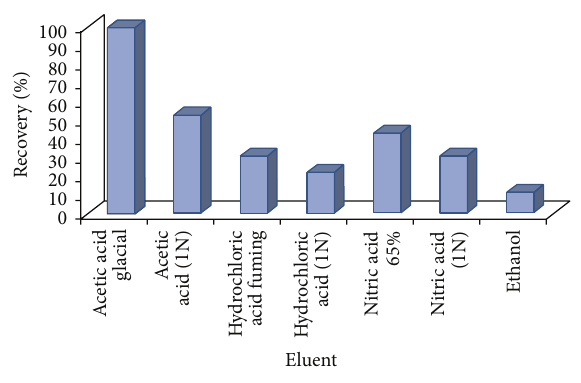
Figure 9: Effects of various eluents on the recoveries of CV (eluent volume: 1mL).